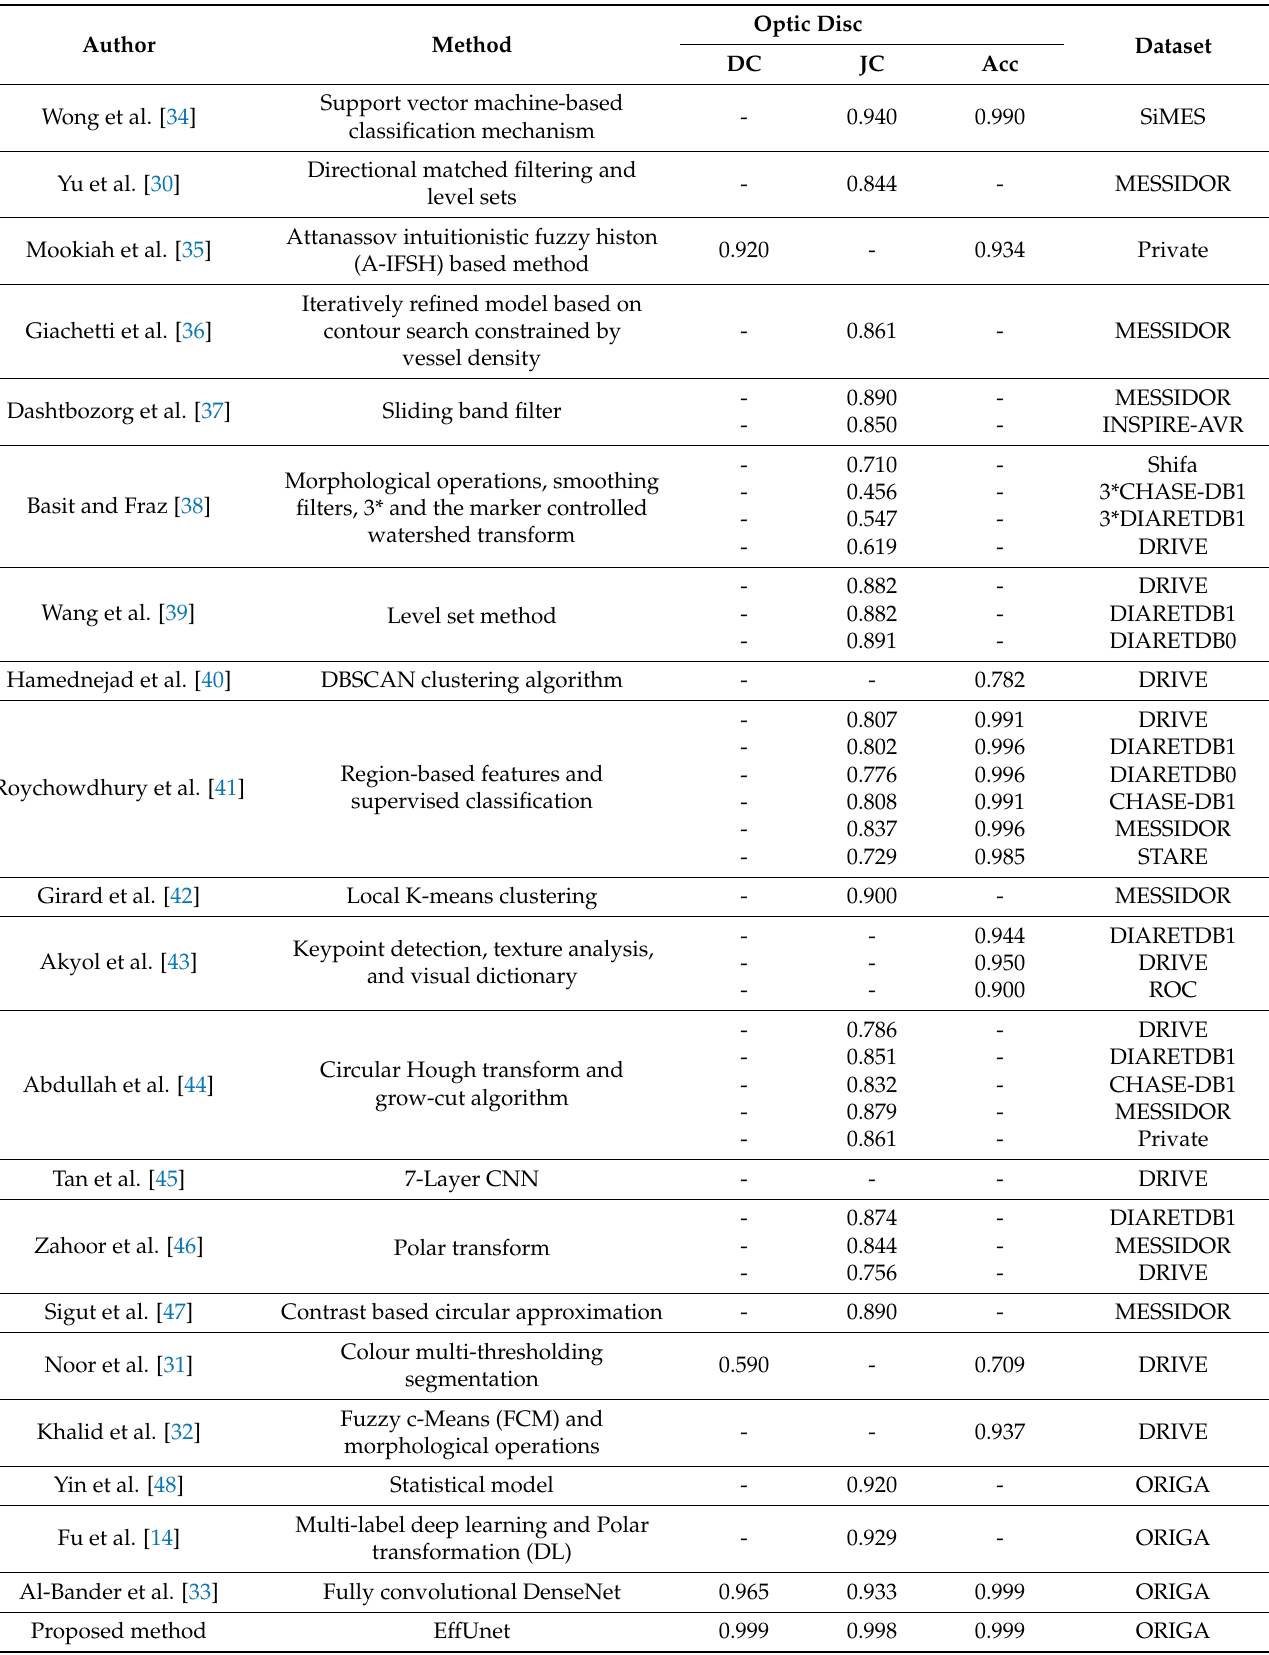
Table 2. Comparison of segmentation methods for optic disc. Note: [31–33] performed segmentations of both cup and